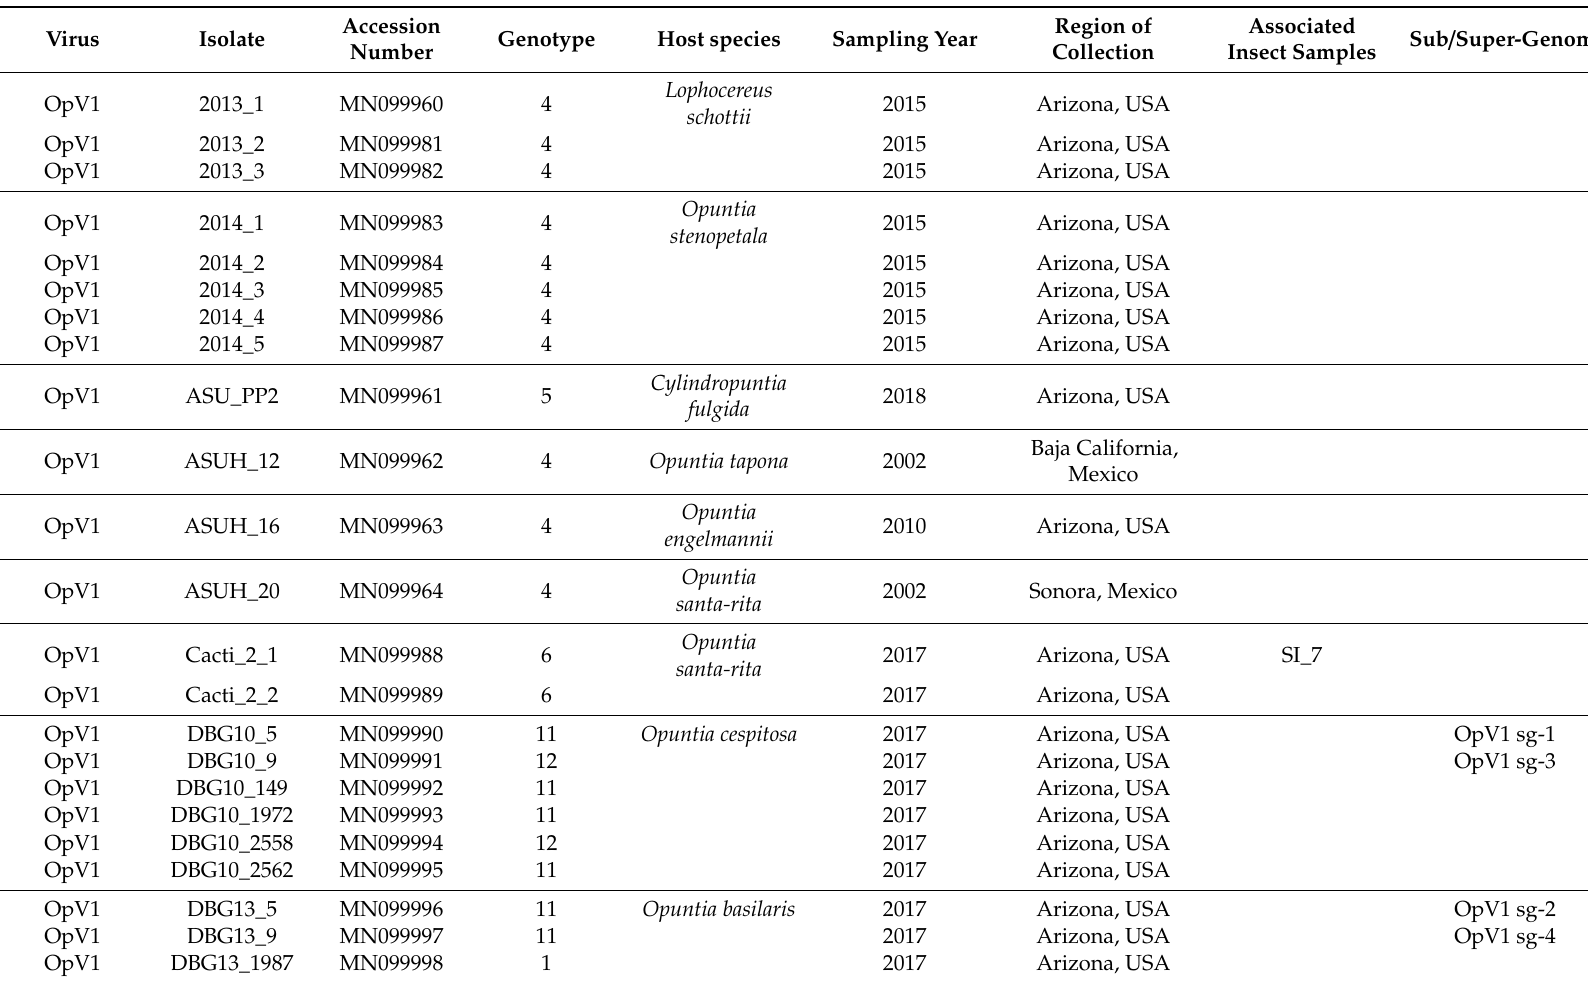
Table 1. Summary of the isolates, accession number, genotype, host species, collection dates and country from which the 79 genomes of the Opuntia virus 1 has been recovered. Details of the cochineal insects sampled and identification of sub / super-genomic molecules from specific plants are